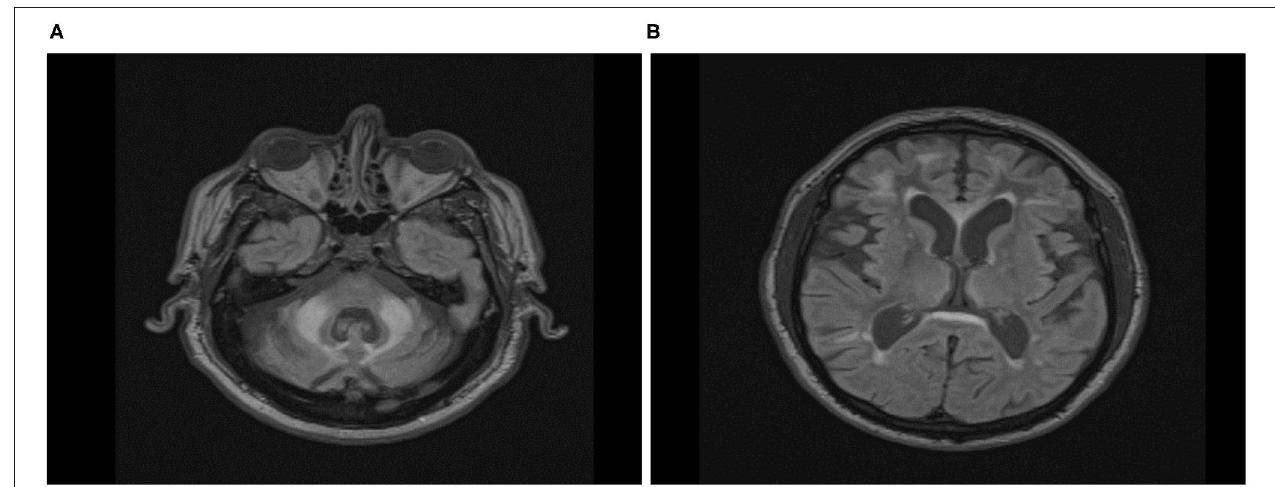
FIGURE 5 | Axial Fluid Attenuated Inversion Recovery (FLAIR) Magnetic Resonance Imaging in FXTAS male (A) and female (B) premutation carriers. (A) Seventy-five-year-old male participant, carrier of 58 CGG repeats, with overt features of FXTAS. ICARS = 22/100; UPDRS = 4/108; CRST:20/156; Prorated IQ = 103. Wmhs scattered in both hemispheres, mainly in the frontal region, thick periventricular and splenial bands, and bilateral MCP sign. (B) Sixty-seven-year-old female participant, carrier of 73 CGG repeats, with overt features of FXTAS and fibromyalgia. ICARS = 19/100; UPDRS = 11/108; CRST:14/156; Prorated IQ = 84. Few small wmhs scattered in both hemispheres, thick periventricular and splenial bands, but absence of whms in middle cerebellar